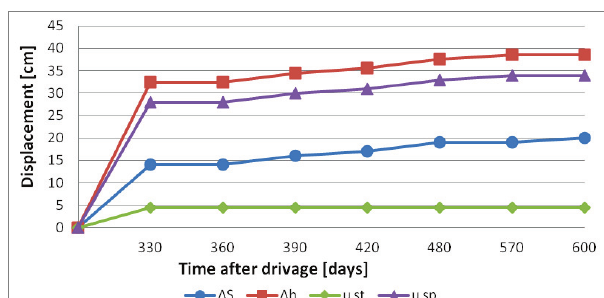
Table 2. Maingate D-2 convergence – base on 930 m Width Floor